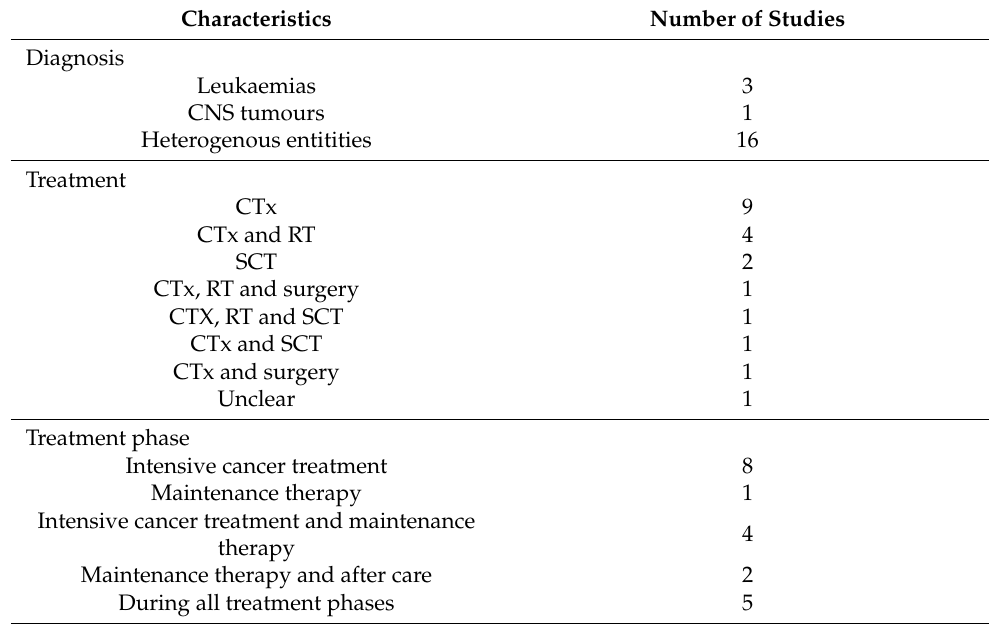
Table 2. Characteristics of the study